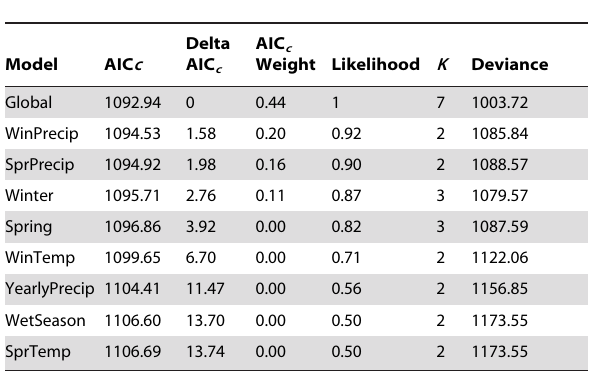
Table 1. Output from 9 a priori models used to assess the relationship between clutch size and seasonal weather patterns for 156 lesser prairie-chicken nests in Roosevelt County, NM, and Cochran, Hockley, Terry, and Yoakum counties, TX, USA, 2001–2011.